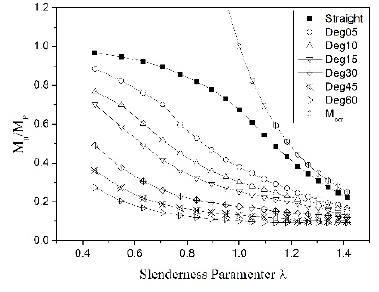
Figure 6. Ultimate Moment Strength Curve.